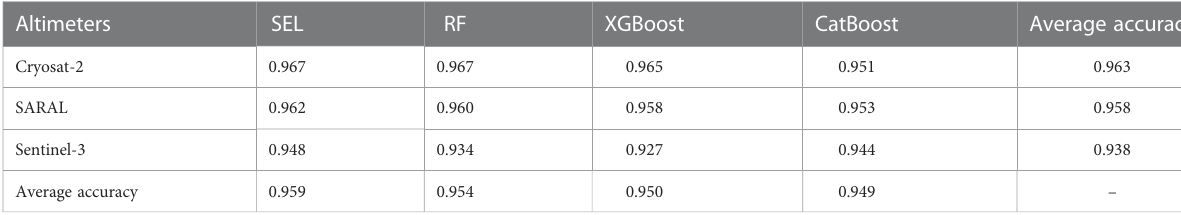
TABLE 3 Comparison of the overall accuracy of coastal waveforms based on four classi fi cation algorithms.